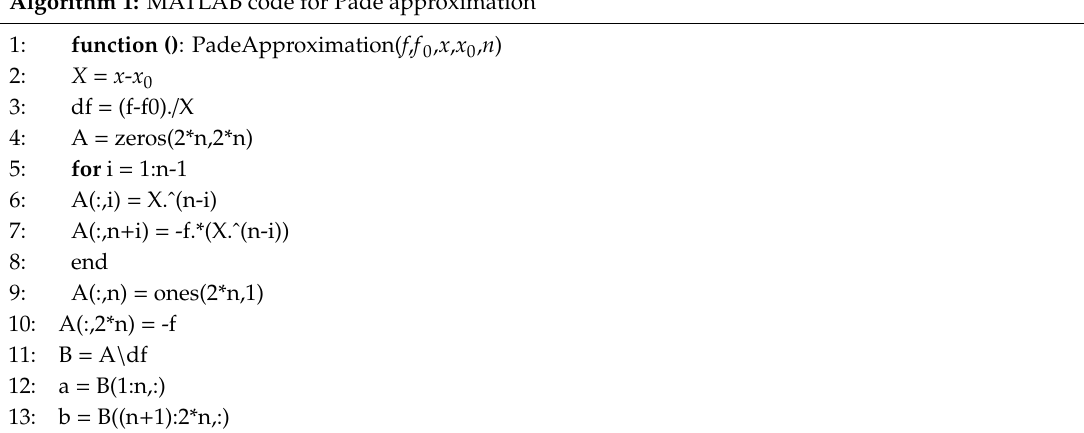
Algorithm 1: MATLAB code for Pad é